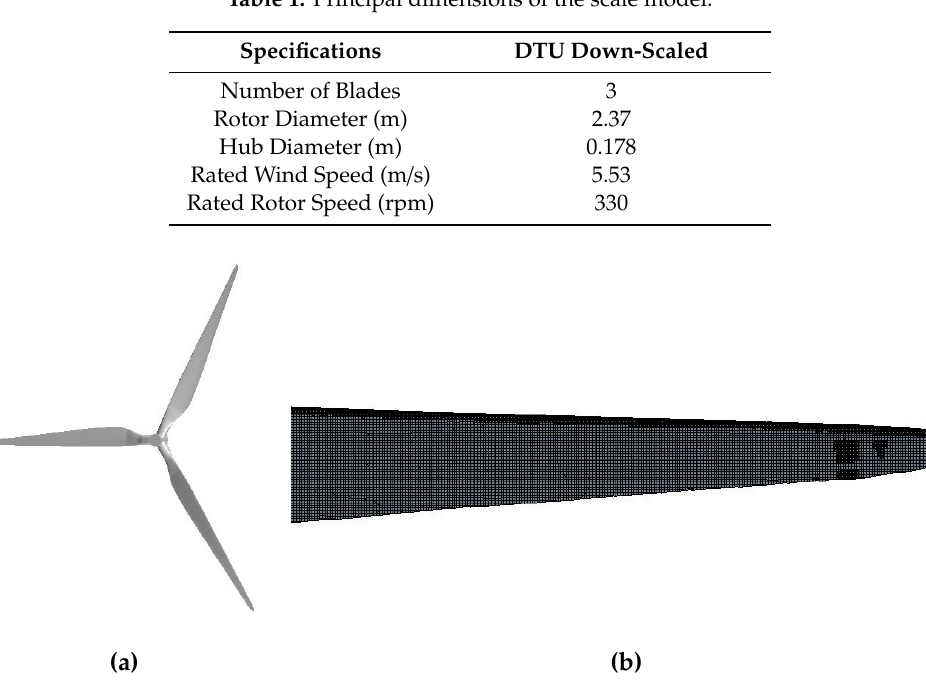
Figure 3. Geometric model and surface grid: ( a ) the rotor geometric model; ( b ) the blade surface grid.